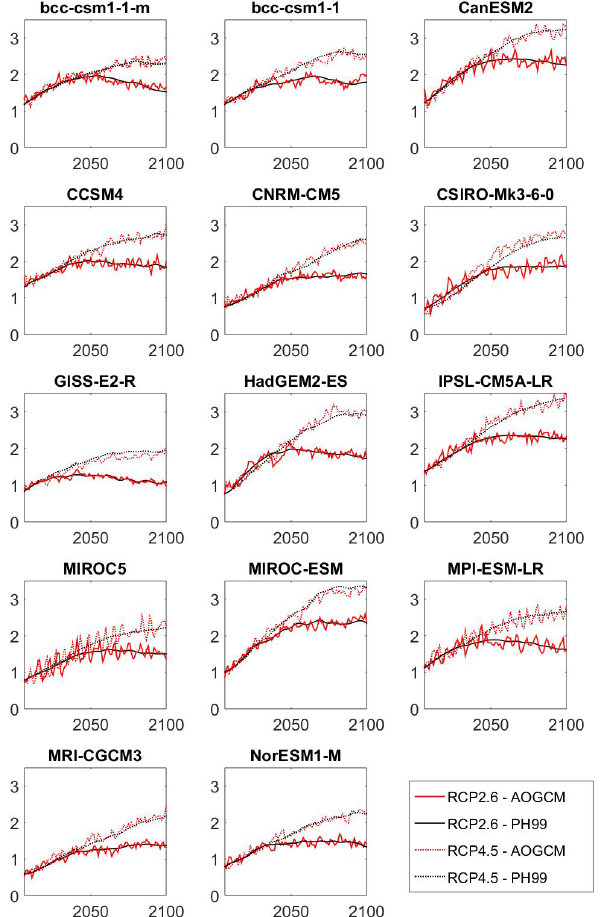
Figure 3. Comparison of temperature evolutions (K) projected by the climate module PH99 (solid and dotted black curves) to the ac- tual AOGCM’s temperature (solid and dotted red curves). α and µ have been tuned to fit the PH99 temperature path (solid black curve) to the respective AOGCM’s RCP2.6 temperature path (solid red curve). Using the fitted α and µ , and taking the forcing recon- structed for RCP4.5 into account, PH99 also reproduces the pro- jected RCP4.5 (dotted black curve). The dotted red curve shows the actual RCP4.5